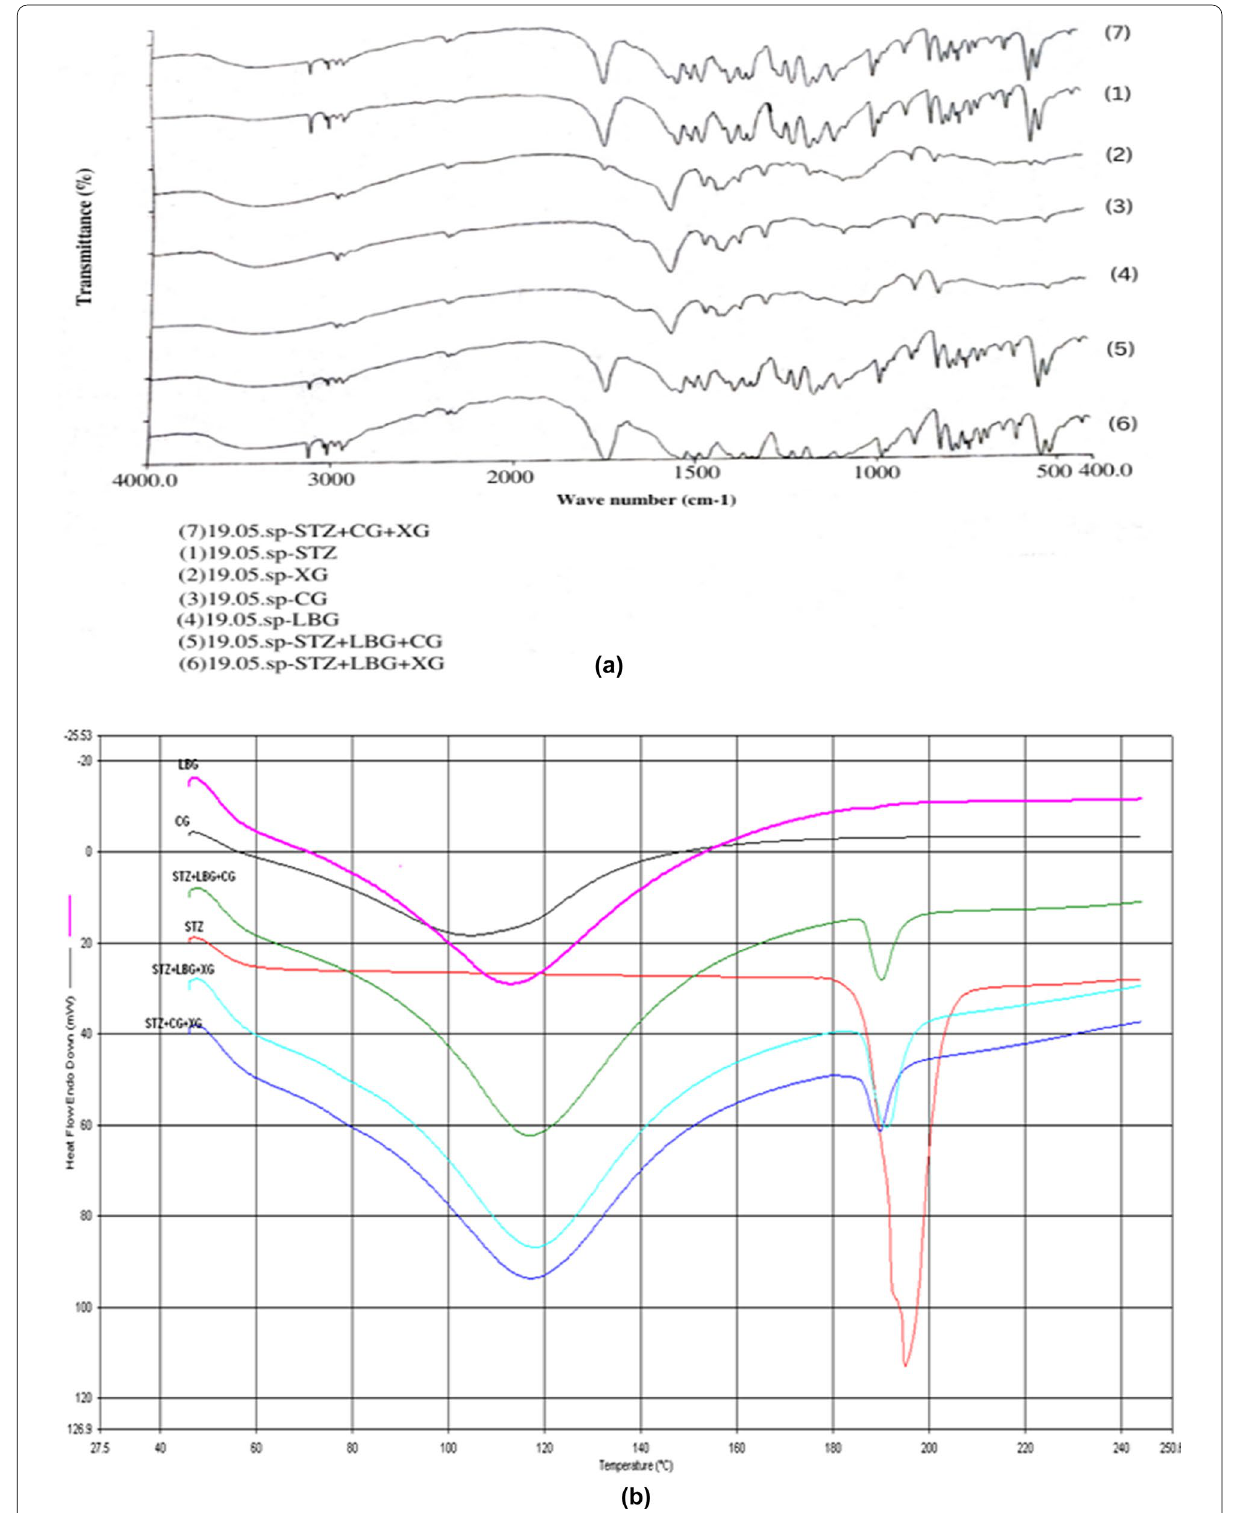
Fig. 1 Drug and polymers interaction studies a FTIR curve of drug &polymer mixture b DSC study of drug and polymer